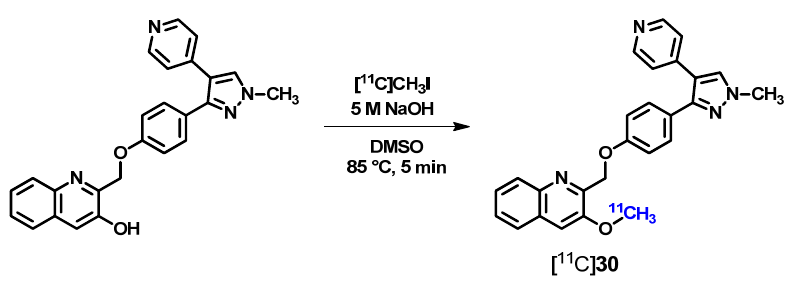
Scheme 10. Radiosynthesis of [ 11 C] 30 . Scheme 10 .